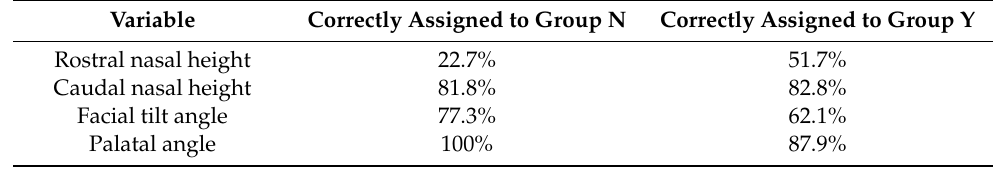
Table 5. Results of the k-means cluster analyses testing the variables that contribute most to the group di ff erentiation in the linear morphometric